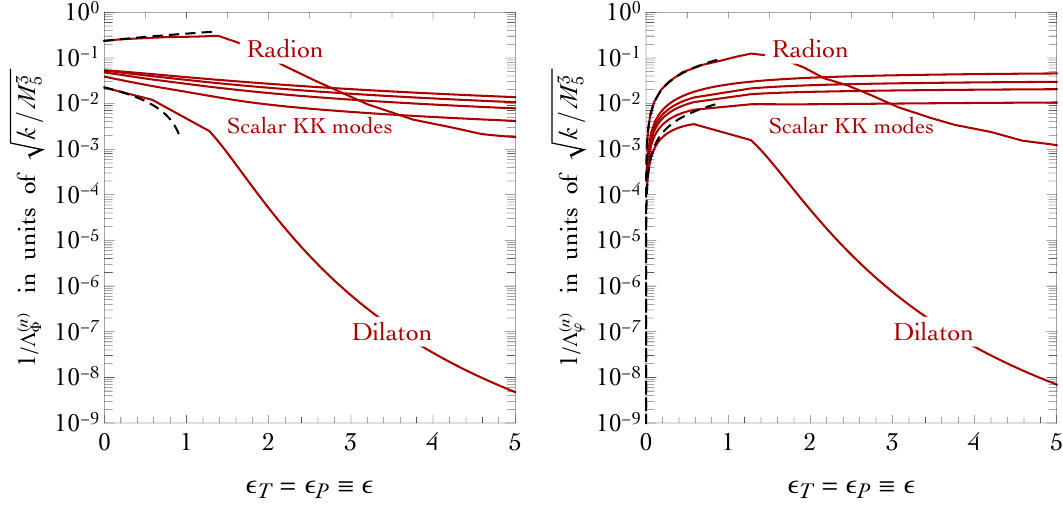
Figure 24 . Scalar couplings with the trace of the energy-momentum tensor (left panel) and the SM Lagrangian (right panel). The dashed black lines (for simplicity, only for radion and dilaton) represent the analytical approximations in eqs. (E.40){(E.43). We only show the (cid:12)rst few modes of the KK